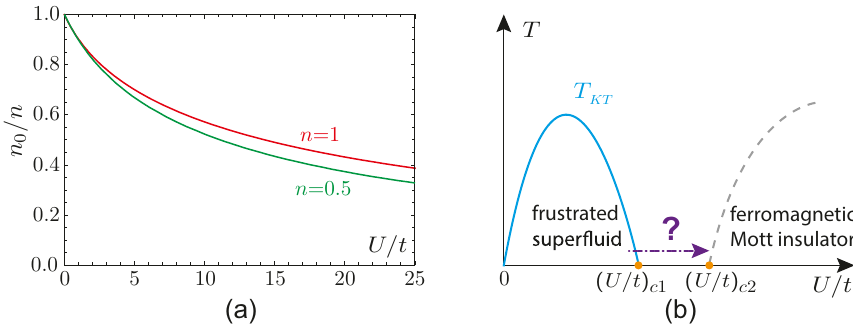
Figure 5 . (a) The condensate fraction n 0 /n as a function of U/t when filling factor n = 0 . 5 and n = 1 . (b) At T = 0 , there could be some kind of quantum spin liquid (QSL) intervening between the frustrated SF at weak coupling and the FM SF at strong